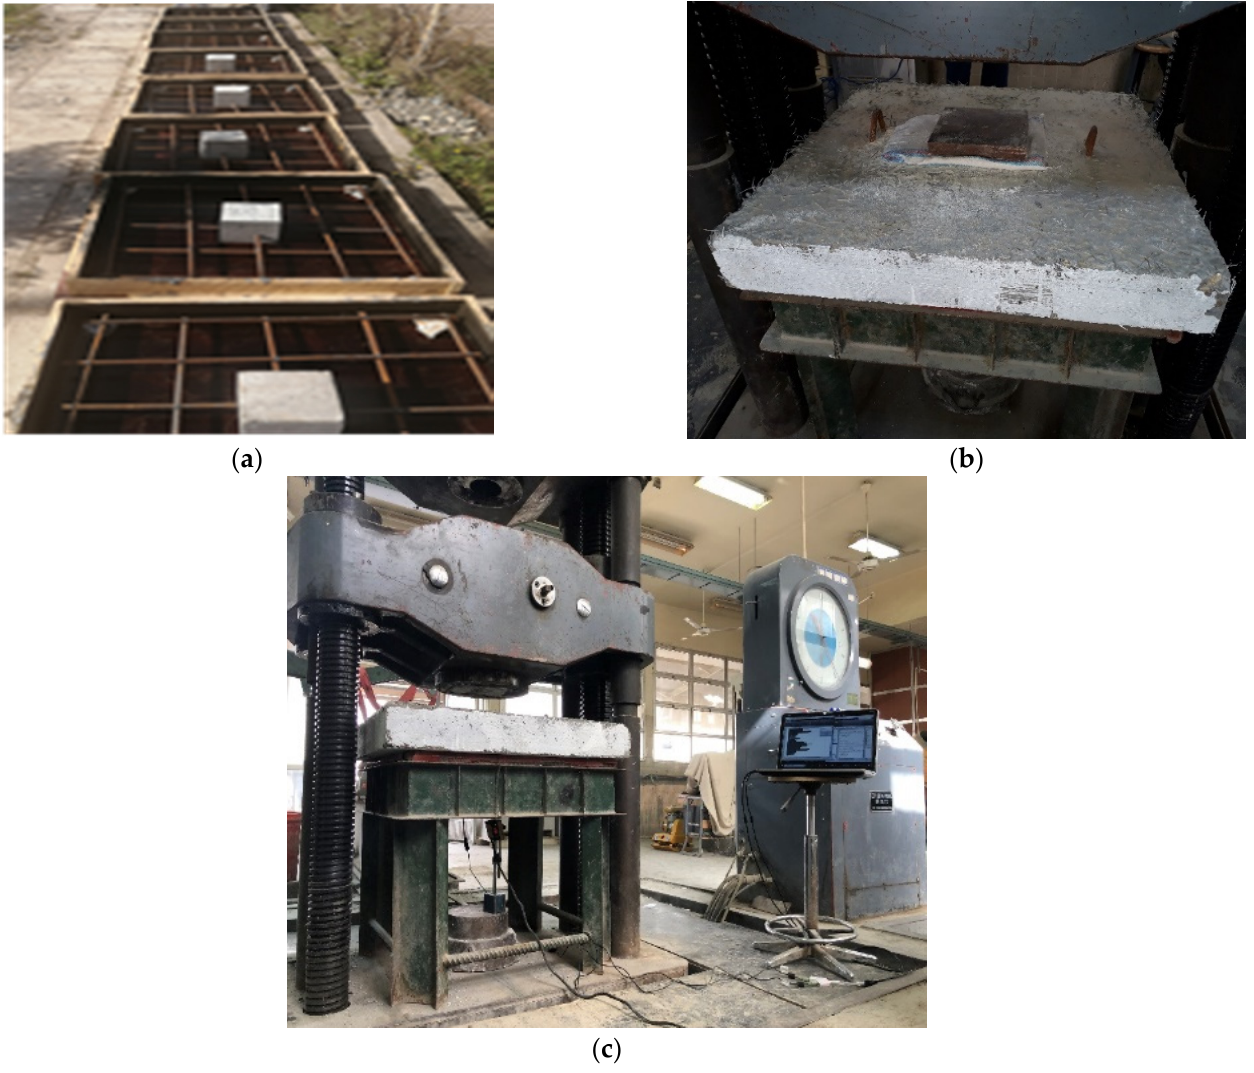
Figure 4. Work process as: ( a ) Wooden form of slab; ( b ) Loading plate; ( c ) Loading setup schematic and measurement devices.